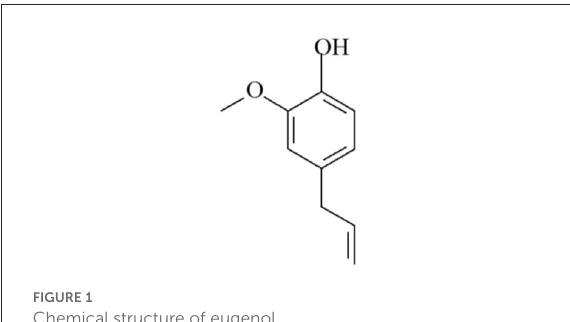
FIGURE1 Chemical structure of